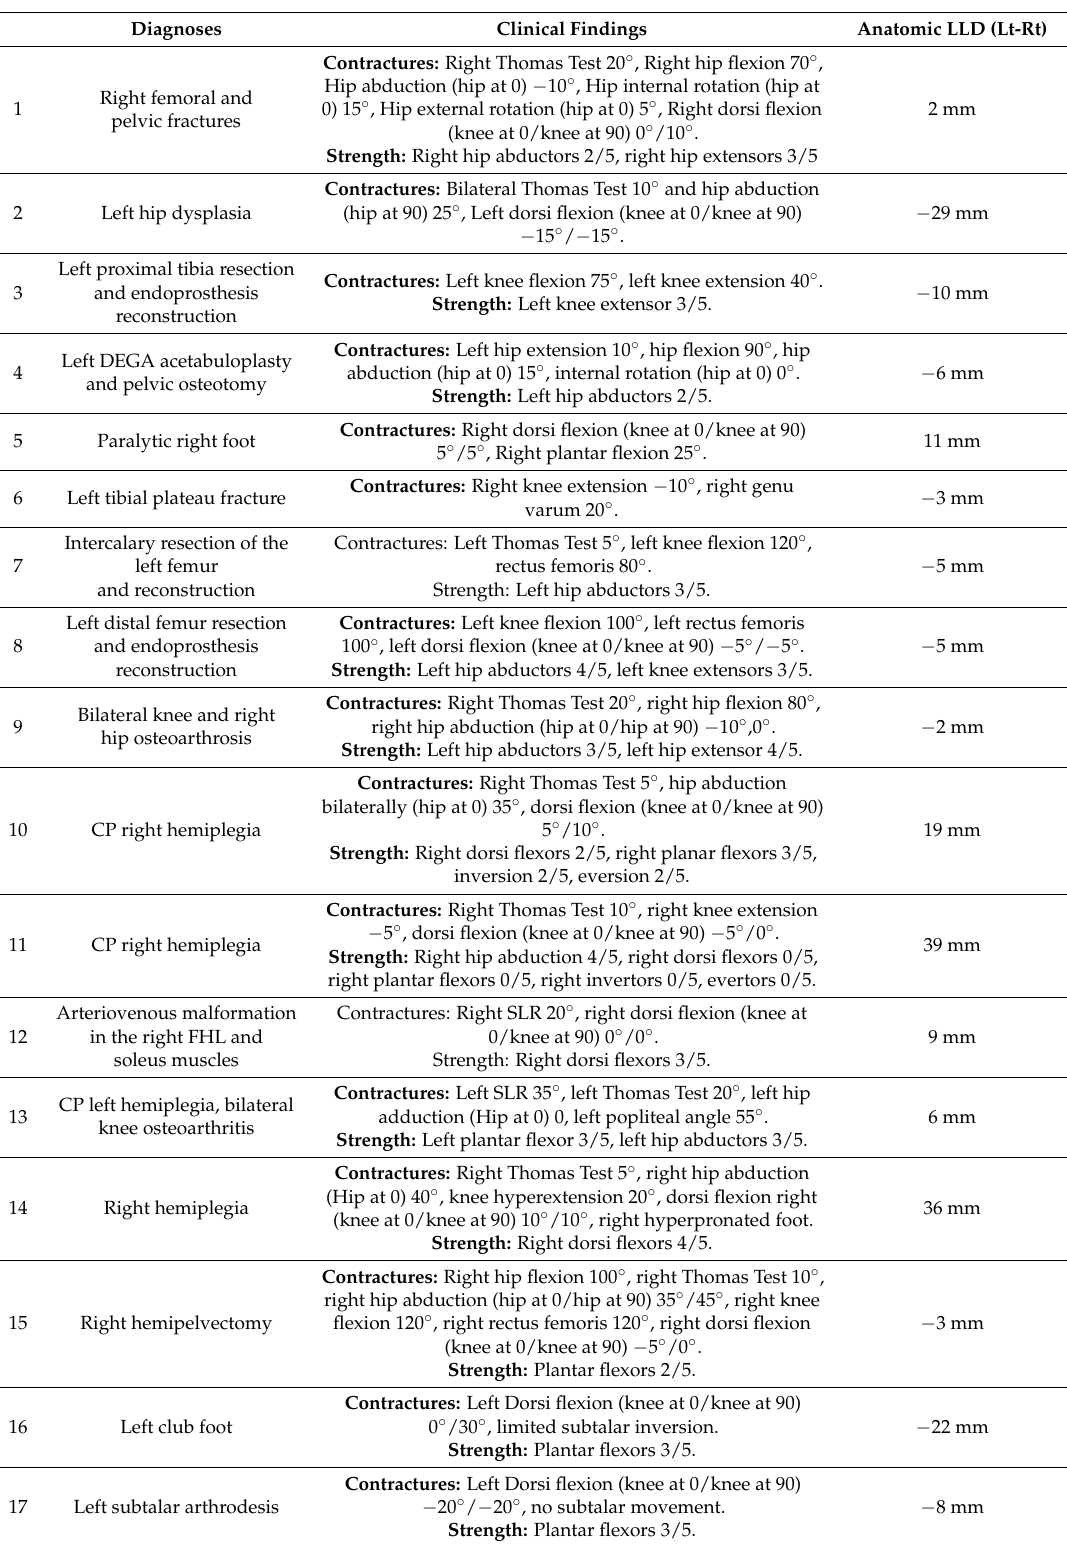
Table 1. Diagnoses and clinical abnormalities among participants in Group